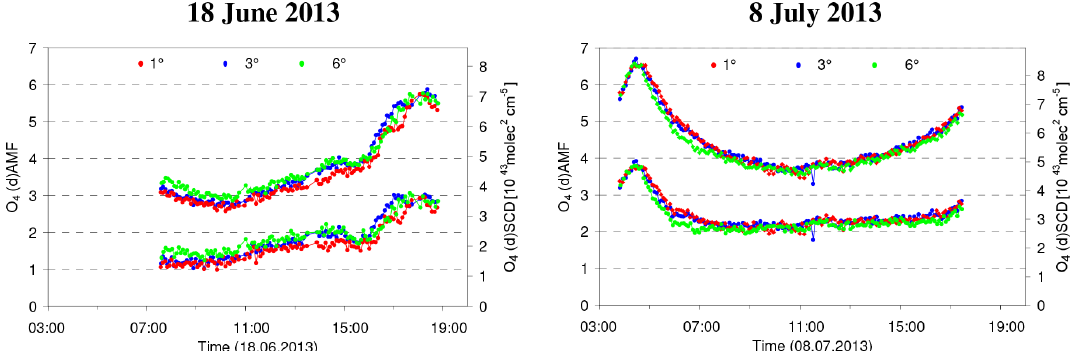
Figure 2. O 4 AMFs (upper lines) and dAMFs (lower lines) for 1, 3 and 6 ◦ elevation angles derived from the MPIC MAX-DOAS mea- surements on the 2 selected days. Interestingly, on 18 June the lowest values are in general found for the lowest elevation angles, which is an indication for the high aerosol load close to the surface. The y axis on the right shows the corresponding O 4 (d)SCDs for O 4 VCDs of